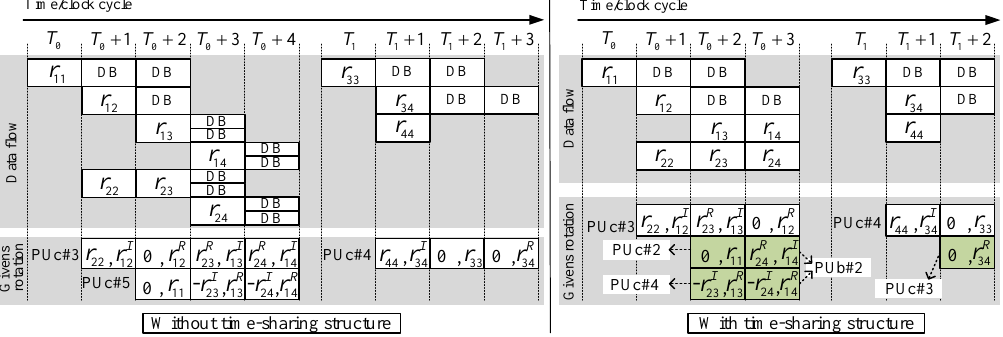
Figure 9. Deeply pipelined processing flow of the proposed SQRD processor with time-sharing Givens rotation structure.